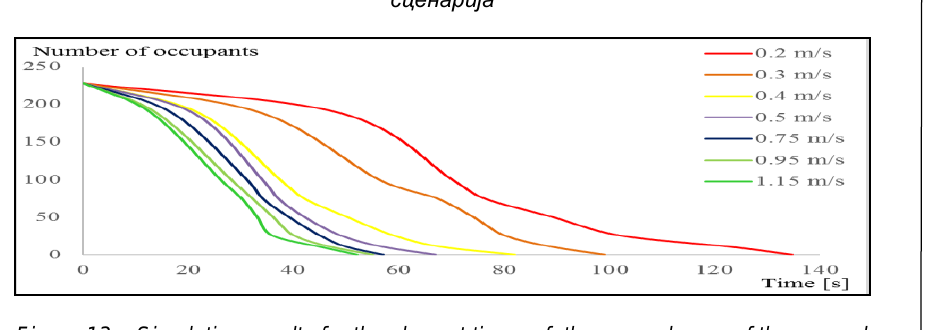
Figure 13 – Simulation results for the slowest times of the second case of the second